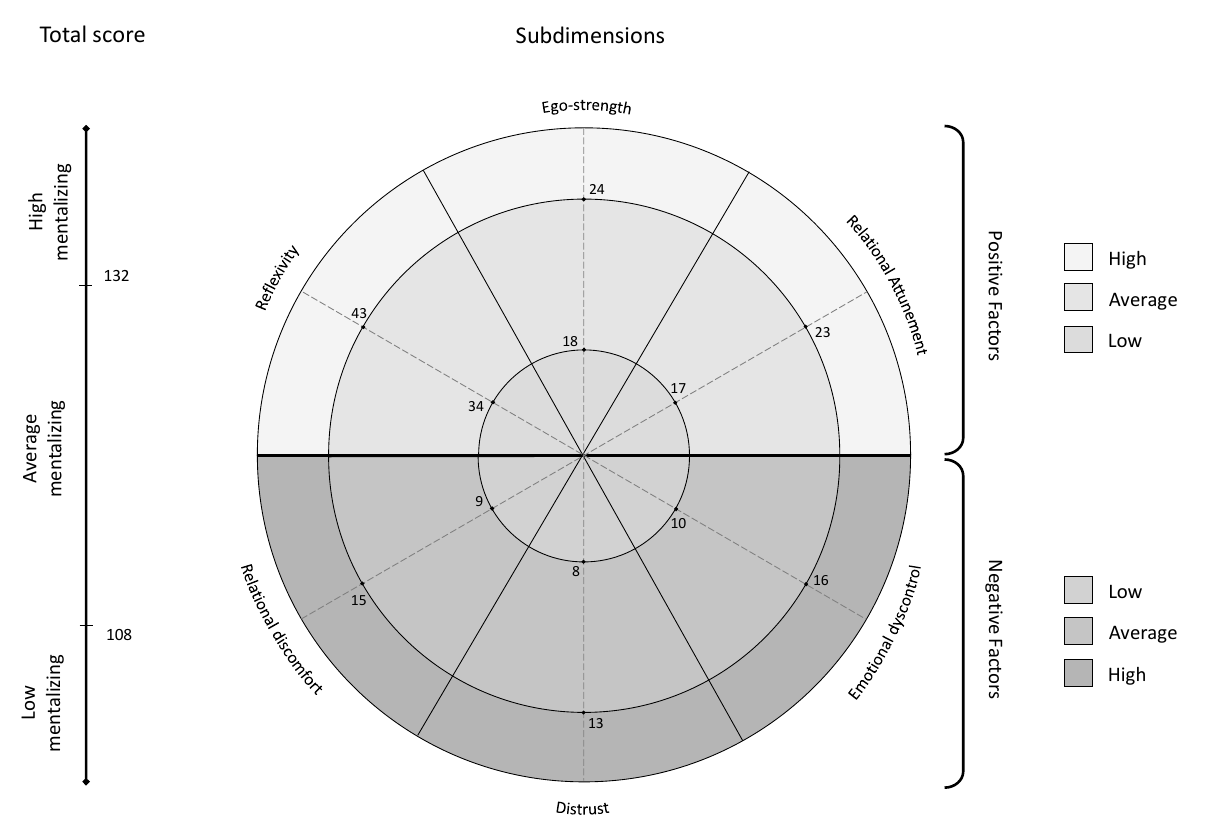
Figure 3. Scoring chart for the Multidimensional Mentalizing Questionnaire.